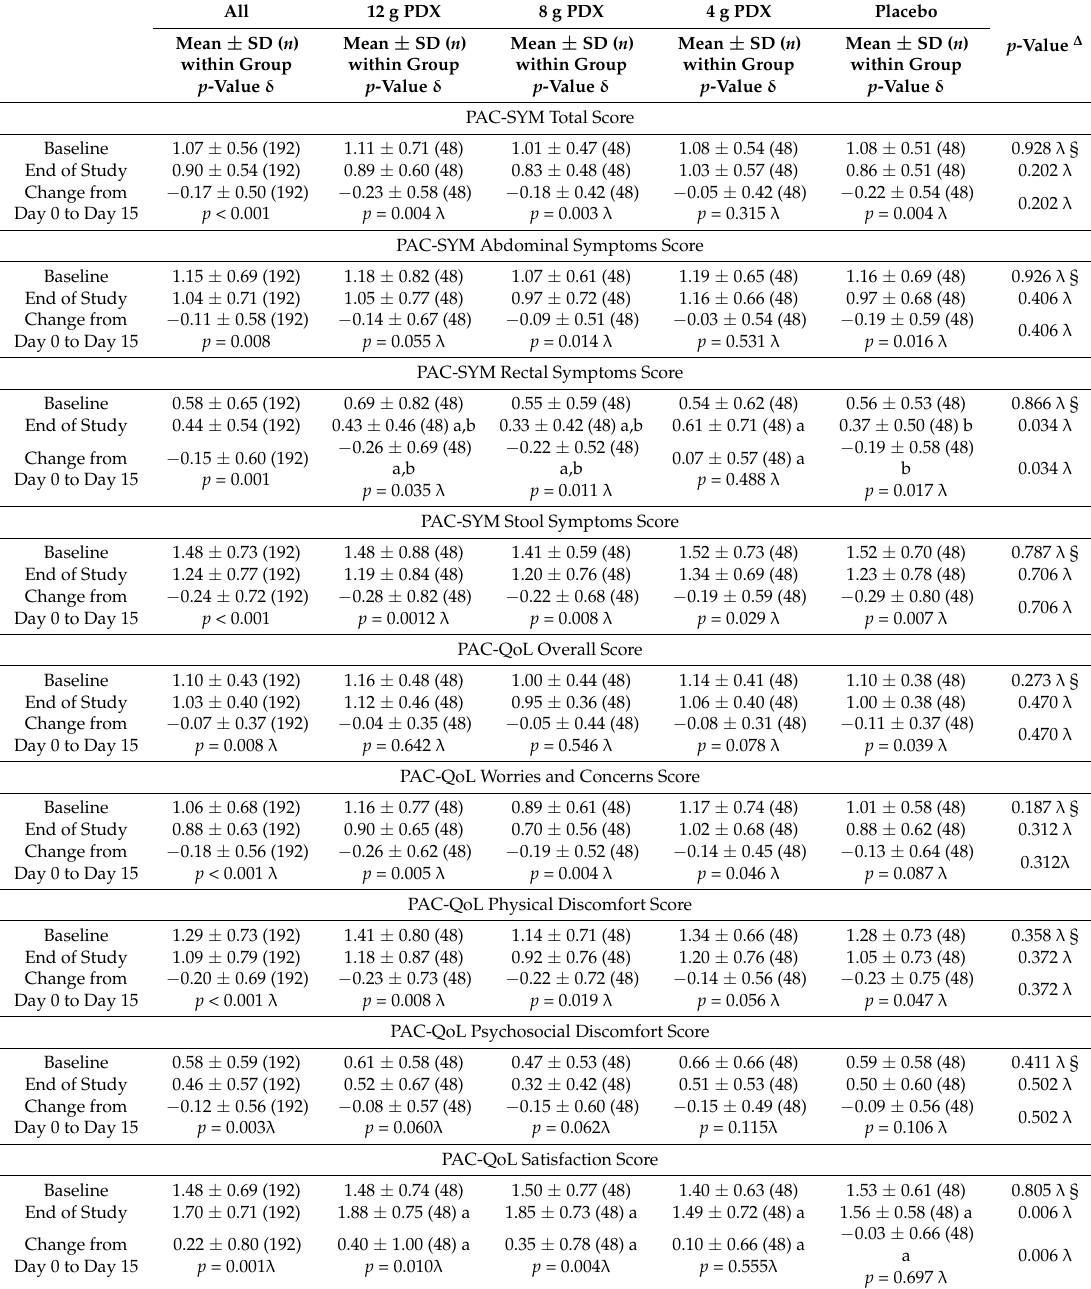
Table 4. Patient assessment of constipation symptoms (PAC-SYM) and quality of life (PAC-QoL) at baseline (Day 0) and end of study (Day 15) for participants in the intention-to-treat population ( n =